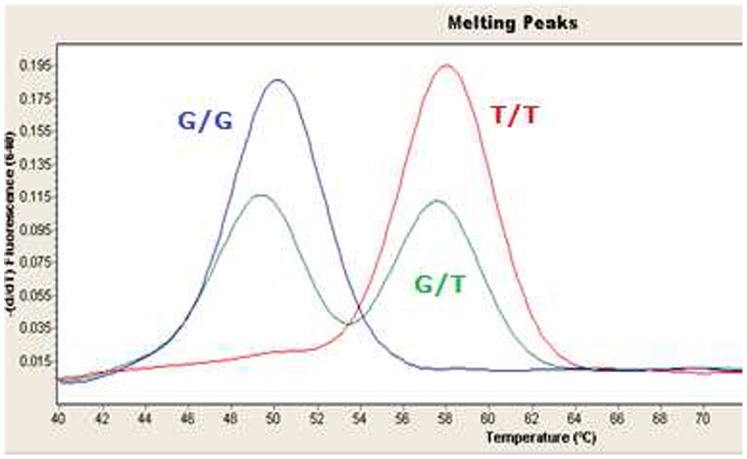
G516T CYP2B6 genotyping by melting curve analysis.Allele-specific derivative melting curve plots for CYP2B6 G516T polymorphism. Fluorescence data were converted to derivative melting curves by plotting the negative derivative of the fluorescence (F) with respect to temperature (T) versus temperature [(dF/dt) vs T] indicating two different melting maxima (Tm), one for the G-allele at 50°C and one for the T-allele at 58°C.